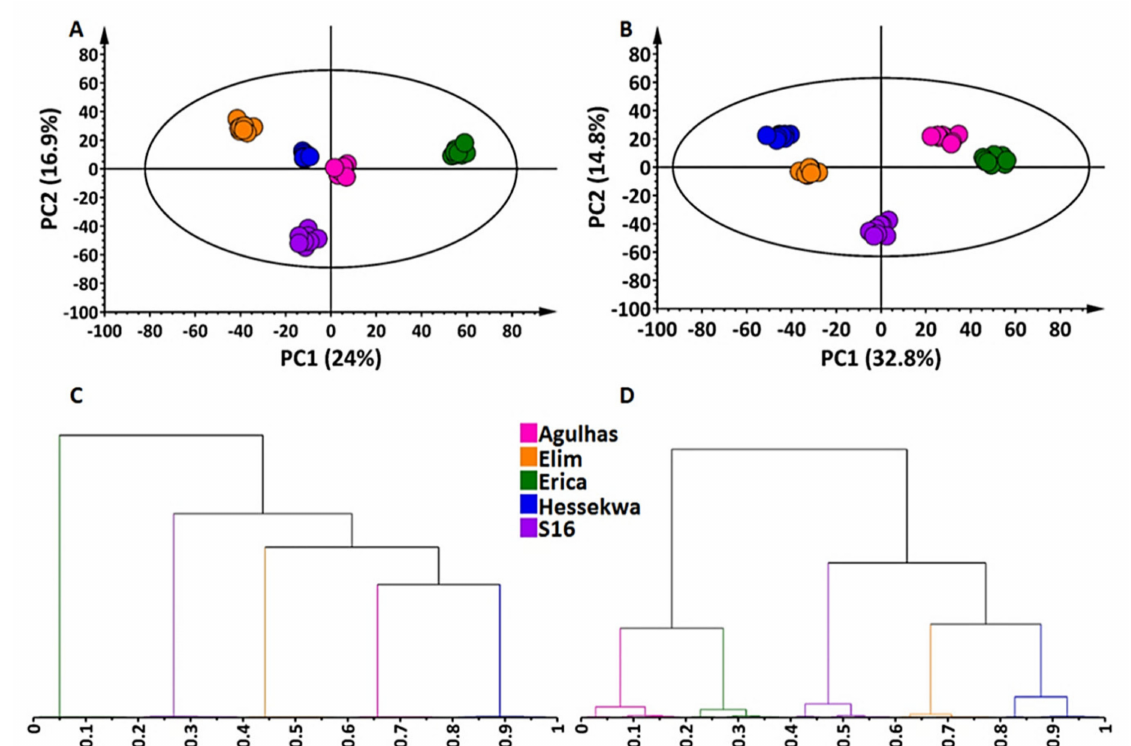
Figure 2. Principal component analysis (PCA) score plots and hierarchical cluster analysis (HiCA) dendrograms of ESI( − ) data from leaf and roots extracts of five cultivars of Hordeum vulgare . The data was mean-centred and Pareto scaled. The calculated Hoteling’s T2 with a 95% confidence interval is represented by the ellipses present in each PCA scores plot. HiCAs were computed on low-dimensional data derived from the corresponding PCA modelling and highlight sub-clustering formed within the samples. The datasets used to compute these models consisted of 1077 features in leaves and 470 in roots. ( A ) A scores plot (PC1 vs. PC2) of a 4-component (PCA) model explaining 60.3% variation and predicting 51.3% variation in leaves; ( B ) A scores plot (PC1 vs. PC2) of a 5-component model explaining 72.3% variation and predicting 62.4% variation in roots; ( C ) HiCA dendrogram corresponding to the PCA model in ( A ) for leaf extracts, and ( D ) HiCA dendrogram corresponding to the PCA model in ( B ) for root